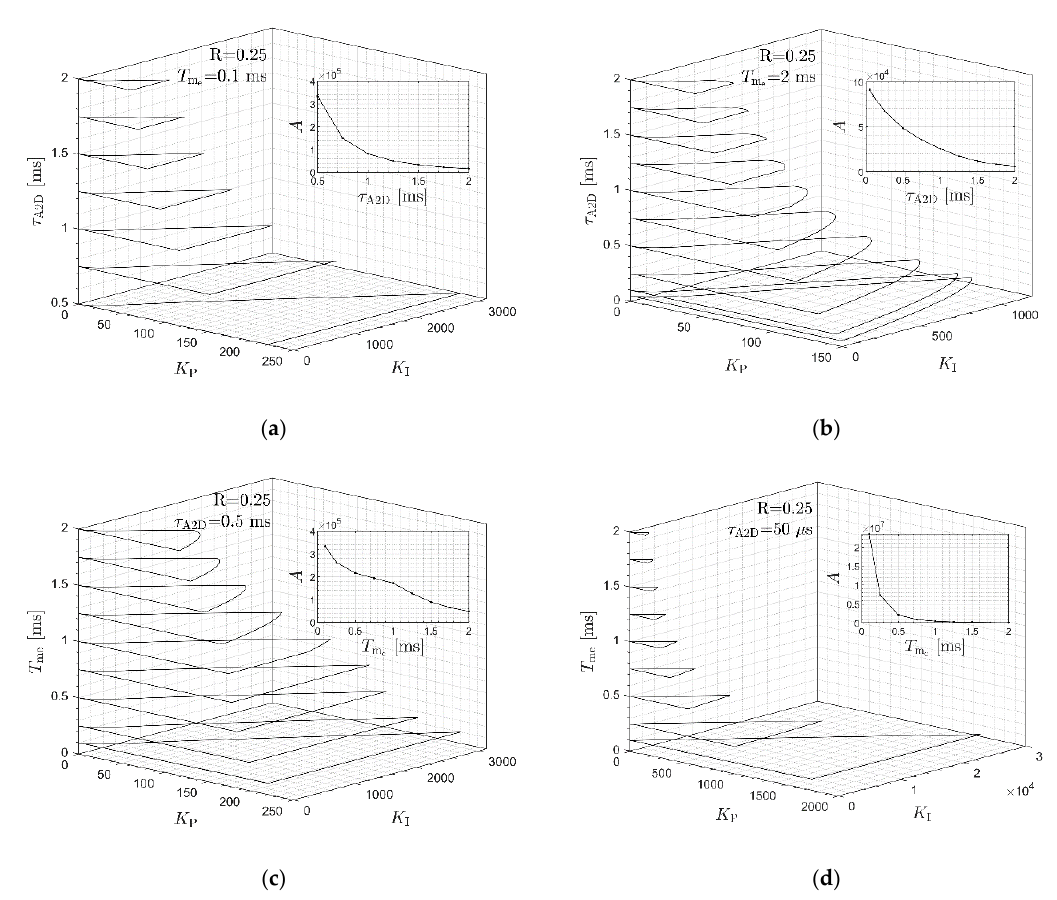
Figure 9. Visualisation of the 𝐾 P and 𝐾 I regions for desired values of 𝐺𝑀 = 20 𝑑𝐵 and 𝑃𝑀 = 70° for the control structure from Figure 2 calculated using D-decomposition technique. Results were obtained for the value of inertia ratio 𝑅 = 0.25 , time constant of the elastic shaft, 𝑇 C = 2.6 ms, and value of electromagnetic torque time constant 𝑇 m = 0.1 ms ( a ) and T m = 2 ms ( b ) and delay from analogue-to-digital conversion in the speed sensor τ A2D = 0.5 ms ( c ) and τ A2D = 50 µ s ( d ). Additionally, the total area, A , of obtained regions were